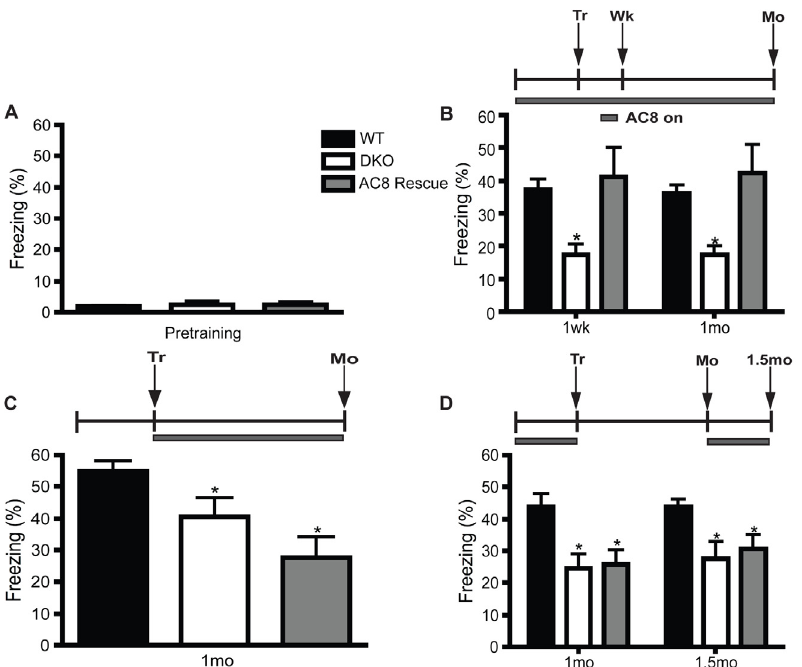
Figure 6. Ca2 + -stimulated AC activity is necessary for memory consolidation and retention. Memory changes are assessed by the overall freezing percentage. ( A ) There are no baseline freezing changes between the genotypes (no differences in baseline freezing levels between graphs B, C, or D, so subjects were combined; p . 0.05). ( B ) DKO mice show memory deficits at 1 wk and 1 mo compared to WT mice. AC8 rescue mice reveal that replacing AC8 expression within the forebrain of DKO mice throughout training, retention and testing is sufficient to rescue CF memory deficits (n=9–11/genotype, *p # 0.05 AC8 vs DKO). Turning AC8 off during ( C ) CF training (n=8–10, *p # 0.05, AC8 and DKO vs WT) or ( D ) during the retention period (n=9–11, *p # 0.01, AC8 and DKO vs WT) prevents restoration of the memory deficits. Furthermore, AC8 rescue mice still show memory deficits after turning AC8 back on for 2 wks after having it off since training (n=9–11, *p # 0.05, AC8 and DKO vs WT). AC8 on = doxycycline off; Symbols: Tr, training; Wk, week; Mo, month.